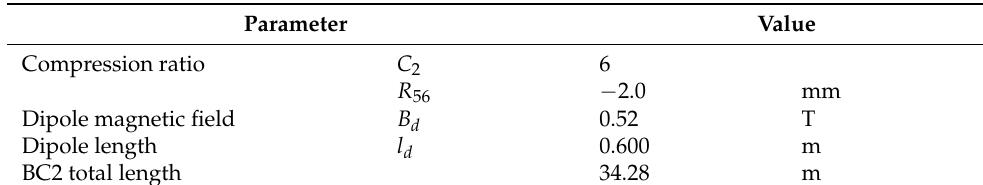
Table 6. BC2 design parameters.